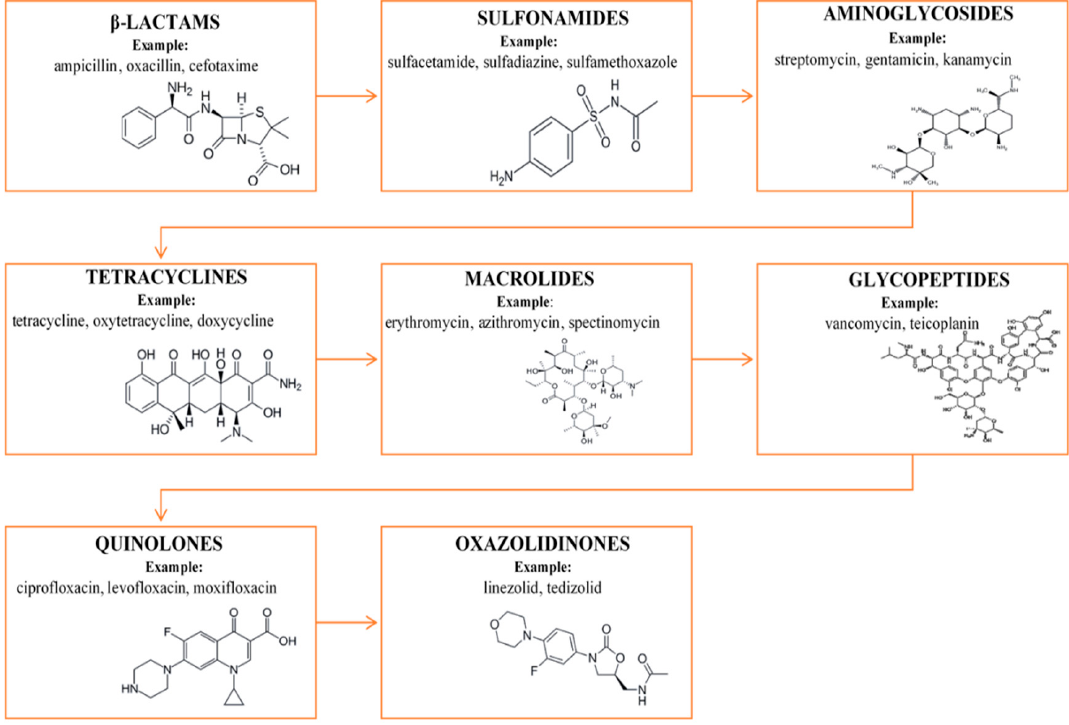
Figure 1. An overview of main antibiotics.